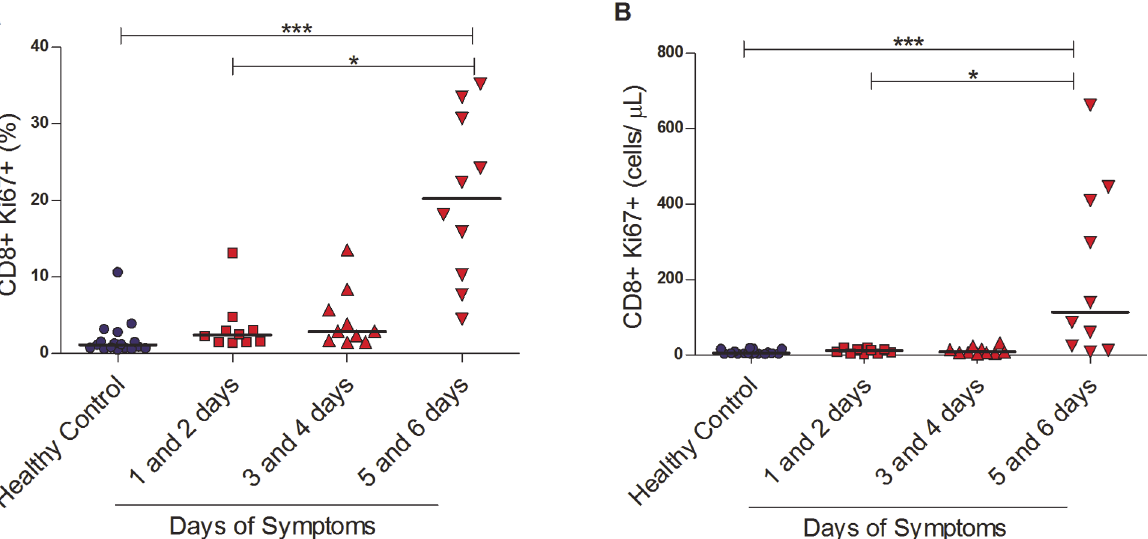
Fig 3. Proliferation of CD8+ T lymphocytes in dengue fever. (A) Percentage and (B) absolute numbers of Ki67+ within CD8+ T lymphocytes in the peripheral blood from healthy controls (n = 17) and dengue fever patients (n = 74) at different days of symptoms. * p < 0.05, *** p < 0.0001.